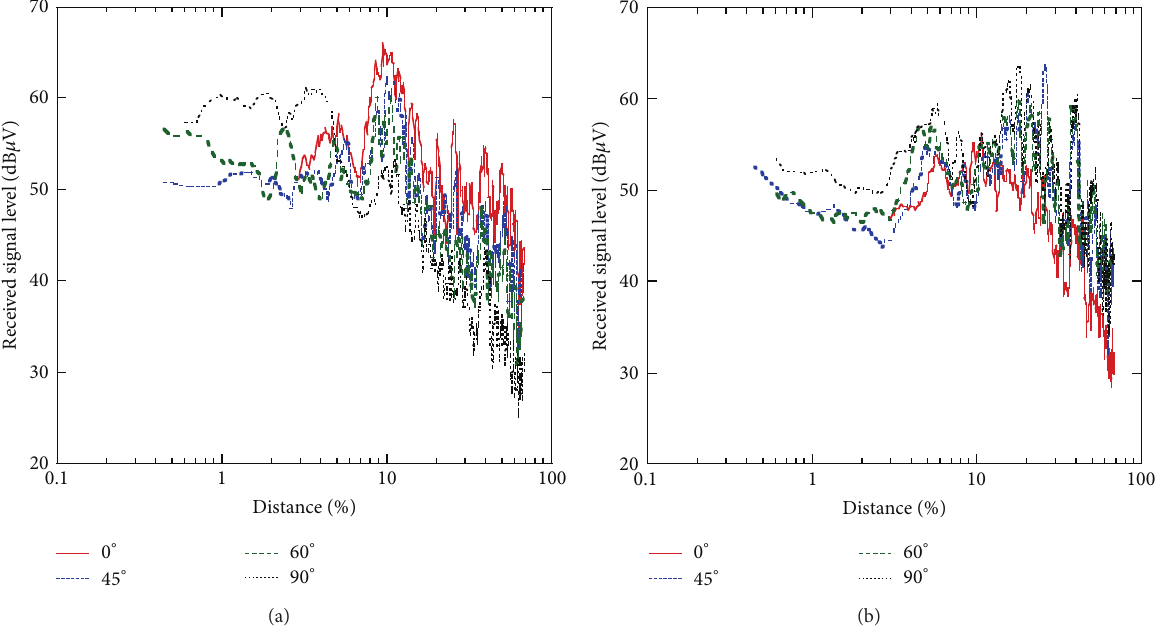
Figure 18: Received-signal level. (a) Collinear with no beam tilt (V antenna). (b) DSCA array with no beam tilt (H